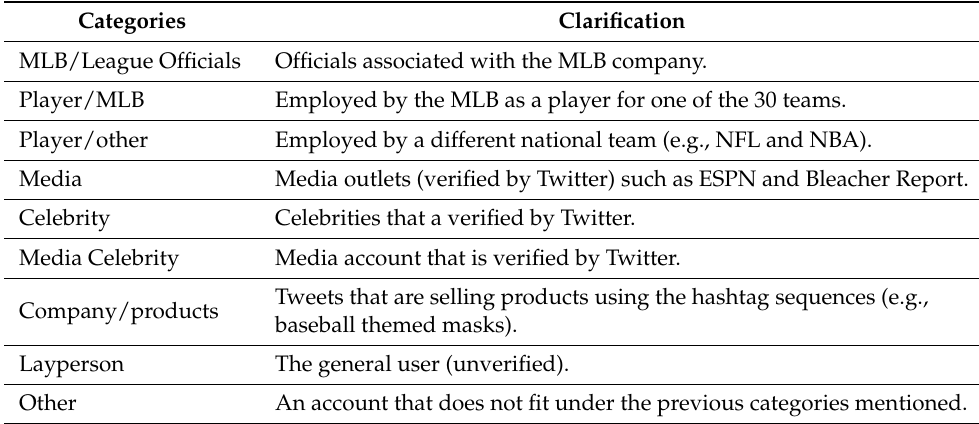
Table 2. Description of tweet source categories and clarification.